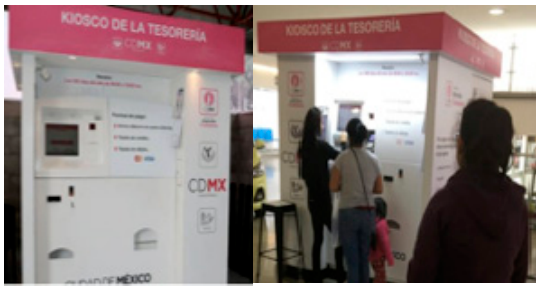
Figure 6. General overview and detailed closeup of Mexico City Government Treasury Kiosk, Mexico.